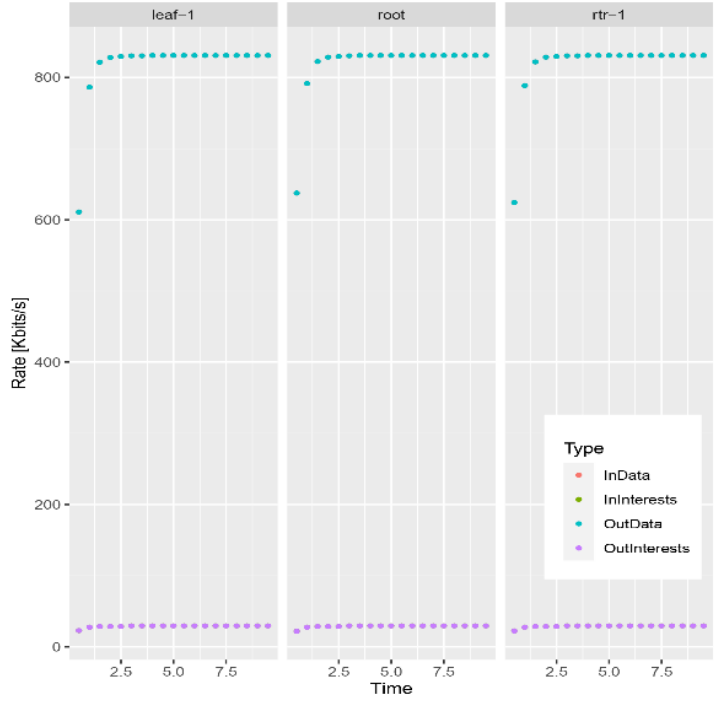
Figure 8. Delay of traditional network.